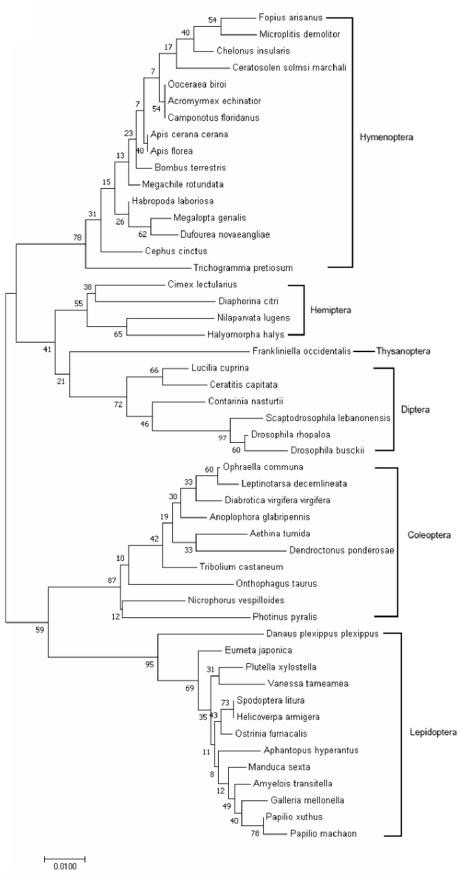
Figure 2. Phylogenetic tree depicting the relationships between the MRLC-sqh proteins of various insects, constructed using the neighbor-joining method with 1000 bootstrap replications. Insects 2020 , 11 , x FOR PEER REVIEW